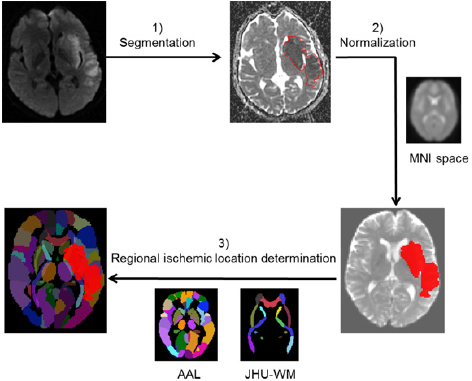
Figure 1. Workflow of lesion location determination: (1) Ischemic lesions were segmented semi- automatically. (2) The generated lesion masks were then normalized to standard Montreal Neuro- logical Institute space using SPM12. (3) The regional ischemic location was determined according to Automated Anatomical Labeling Atlas and the Johns Hopkins University White Matter Labels (1 mm) Atlas. Abbreviations: MNI = Montreal Neurological Institute; AAL = Automated Anatomical Labeling Atlas; JHU-WM = Johns Hopkins University White Matter Labels (1 mm) Atlas.